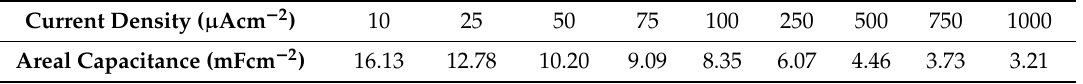
Table 3. Areal capacitance values of the sheet-like ZnCo 2 O 4 microstructure electrode.